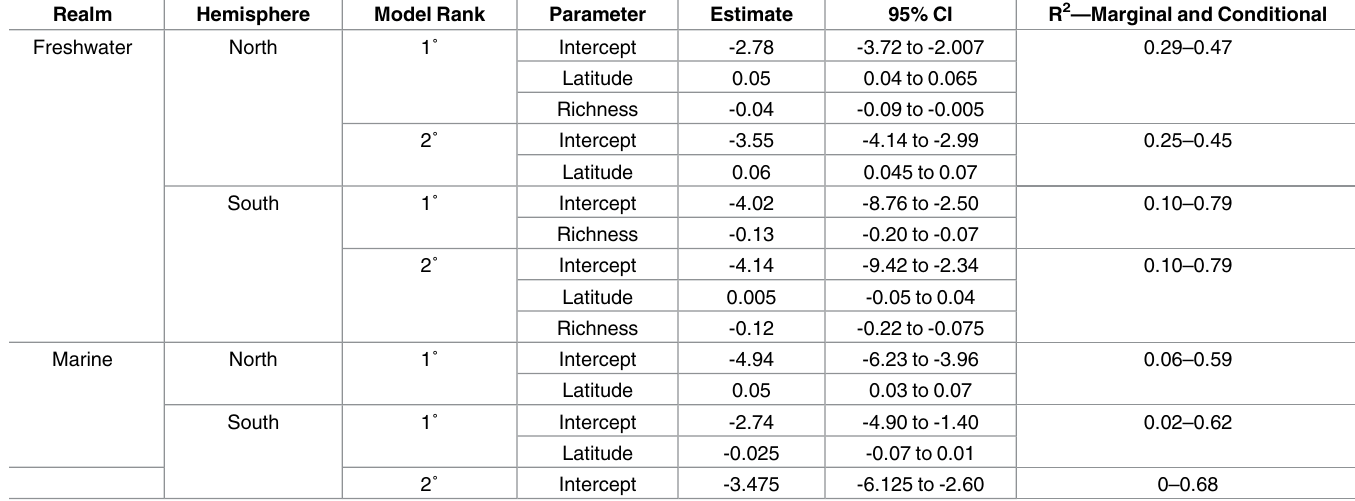
Table 2. Parameterestimation of the best models (GLMM with delta AIC lower than 2) predicting occurrence of cannibalism for both freshwater and marine realm in Northern and Southern hemispheres. Realm